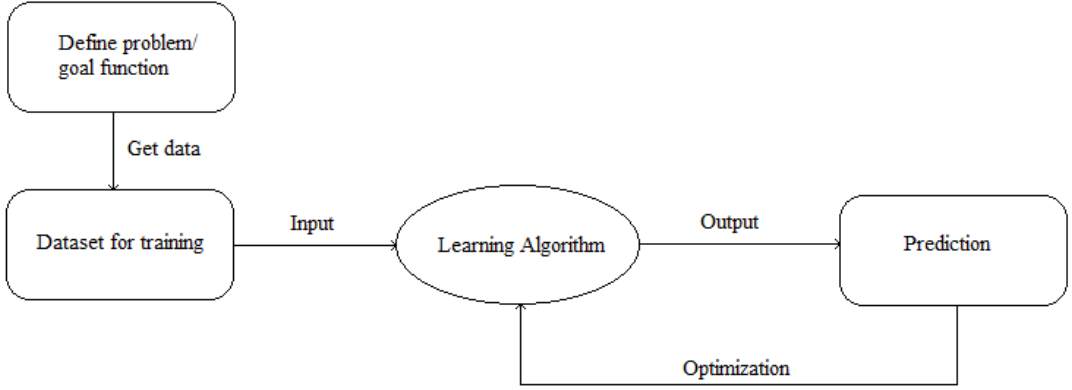
Figure 1. Practical implementation of a machine learning algorithm.